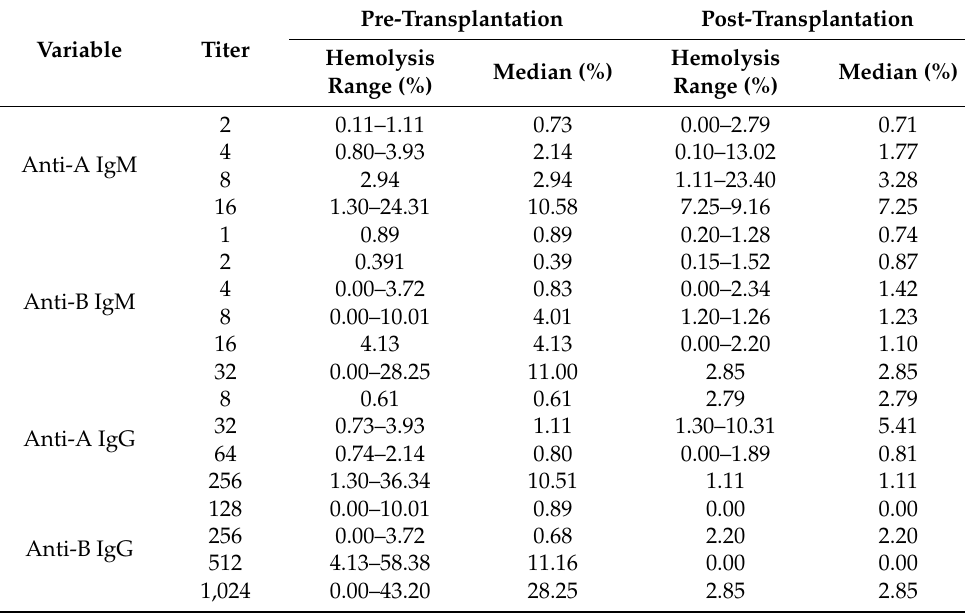
Table 3. Hemolysis range (%) according to ABO Ab titer before and after transplantation. The titer indicates ABO Ab titer of agglutinin titration test in blood group